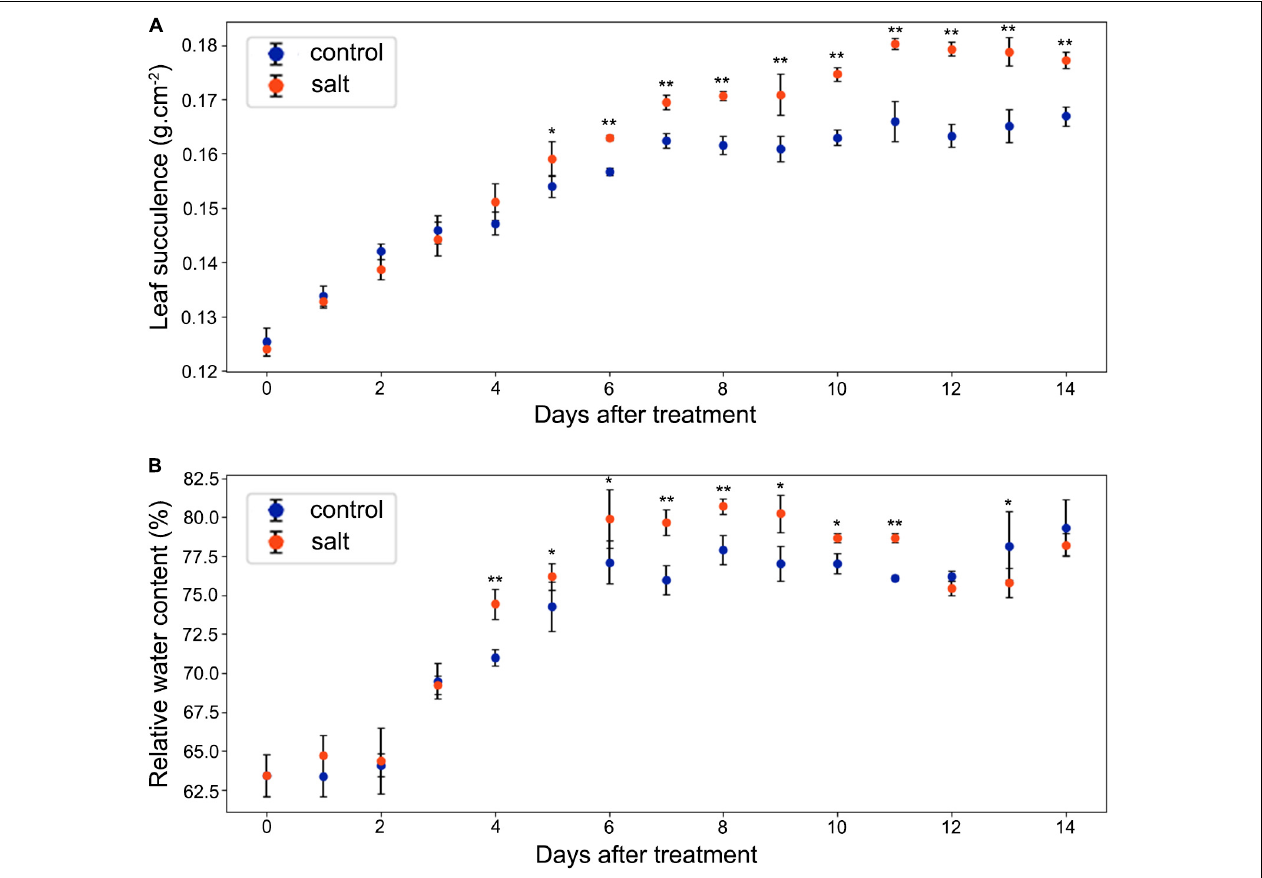
FIGURE 4 | Changes in leaf succulence and relative water content (RWC) in the control and salt-treated M. crystallinum seedlings. (A) Leaf succulence. The blue dots represent the control group and the orange dots represent the salt-treated group. The error bar represents standard error. (B) RWC. The blue dots represent the control group and the orange dots represent the salt-treated group. The error bar represents standard error. An asterisk indicates a Student’s t- test ( p < 0.05) and two asterisks indicate a Student’s t- test ( p < 0.01). The data were obtained from four biological